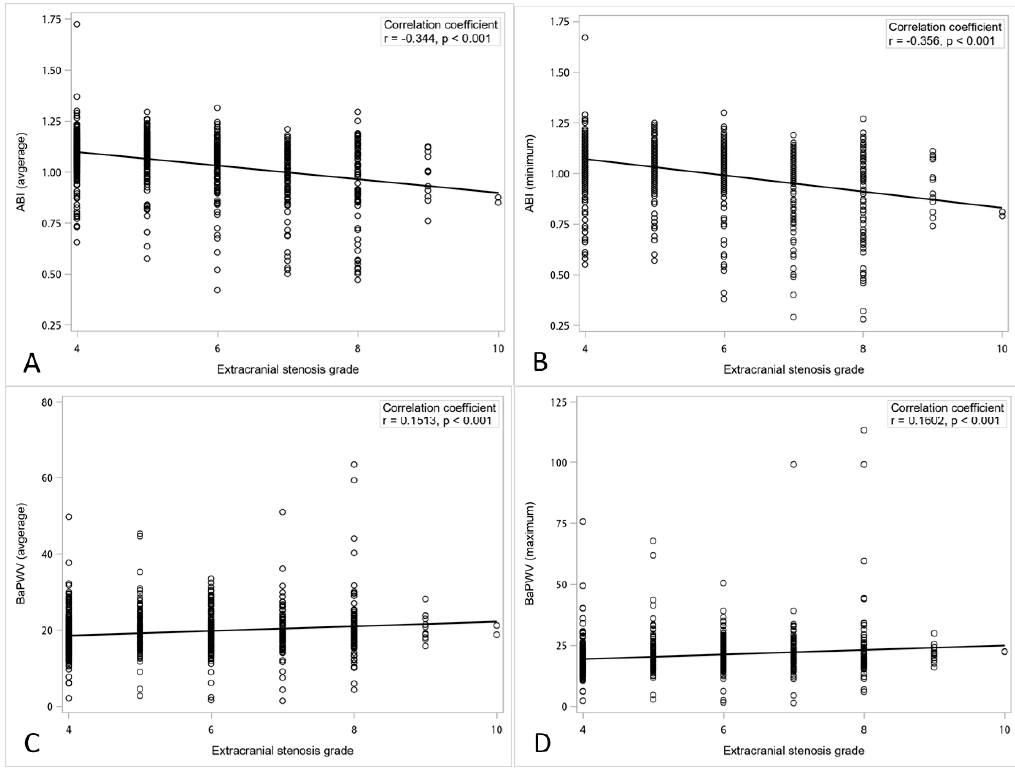
Figure 1. Relationship between the ABI/baPWV and extracranial vessel stenosis. ( A , B ) The correla- tion between the average and minimum ABI and extracranial vessel stenosis. ( C , D ) The correlation between the average and maximum baPWV and extracranial vessel stenosis.